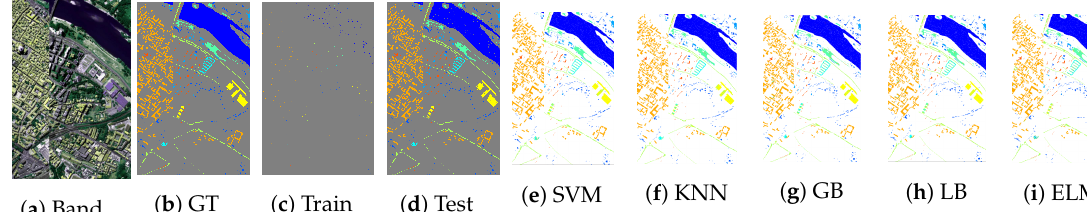
Figure 8. Pavia University: ( a ) Ground Band, ( b ): True Ground Truths, ( c ): Training Ground Truths, ( d ): Test Ground Truths, and ground truths predicted by ( e ): SVM, ( f ): KNN, ( g ): GB, ( h ): LB, and ( i ): ELM classifier with 2% of selected training samples.